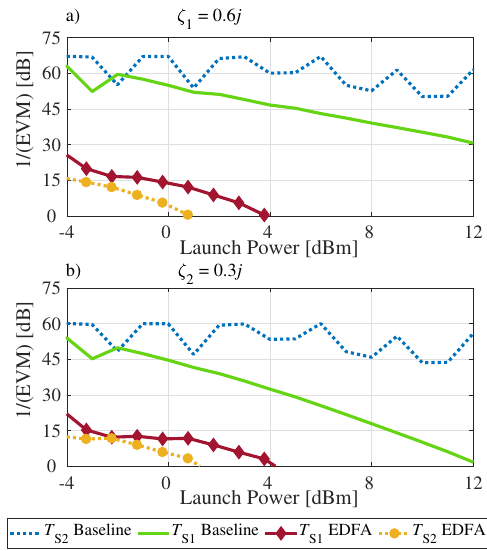
Figure 11. The reciprocal of the EVM as a function of the launch power when the system includes only fiber losses with lumped gain from EDFAs. ( a ) Results of the signal decoded from the first eigenvalue ζ 1 = 0.6 j . ( b ) Results of the signal decoded from the second eigenvalue ζ 2 = 0.3 j . We show results for the system with a symbol period equal to T S1 and for the system with a symbol period equal to T S2 = 2 T S1